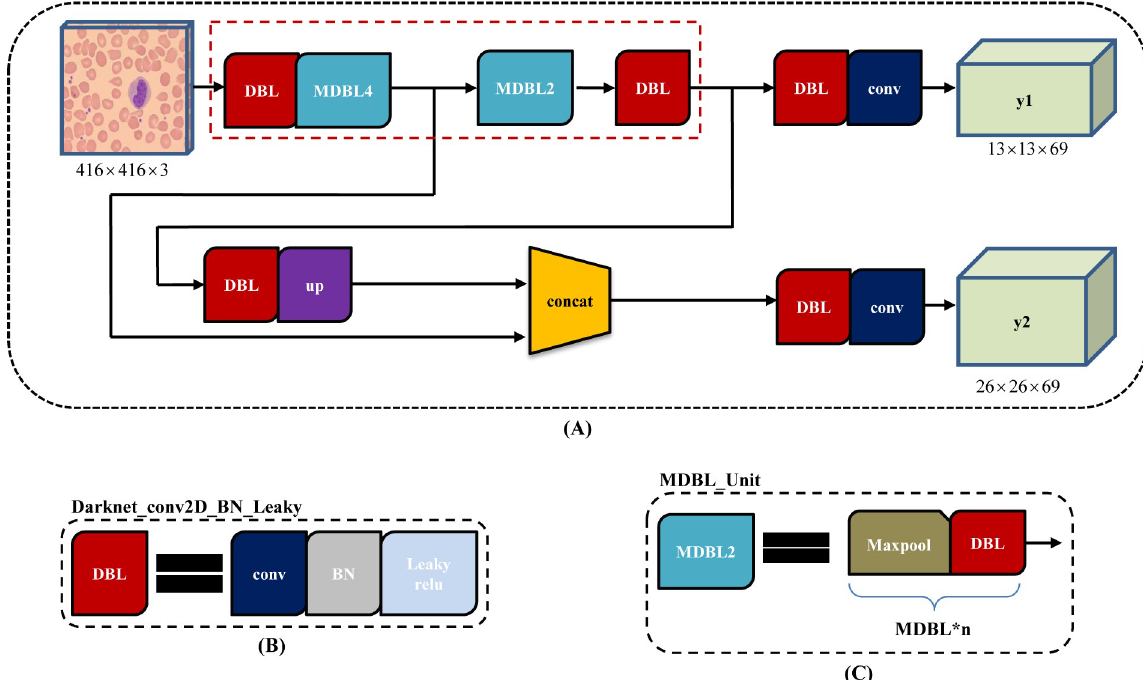
Fig 6. YOLOv3-tiny architecture. (A) the pipeline of YOLOv3 with 2 branch outputs, y1 and y2; (B) the basic element, composed of one convolution layer, one batch normalization layer and one leaky relu layer; (C) one maxpool layer and one "DBL" structure form into "MDBL_Unit" for